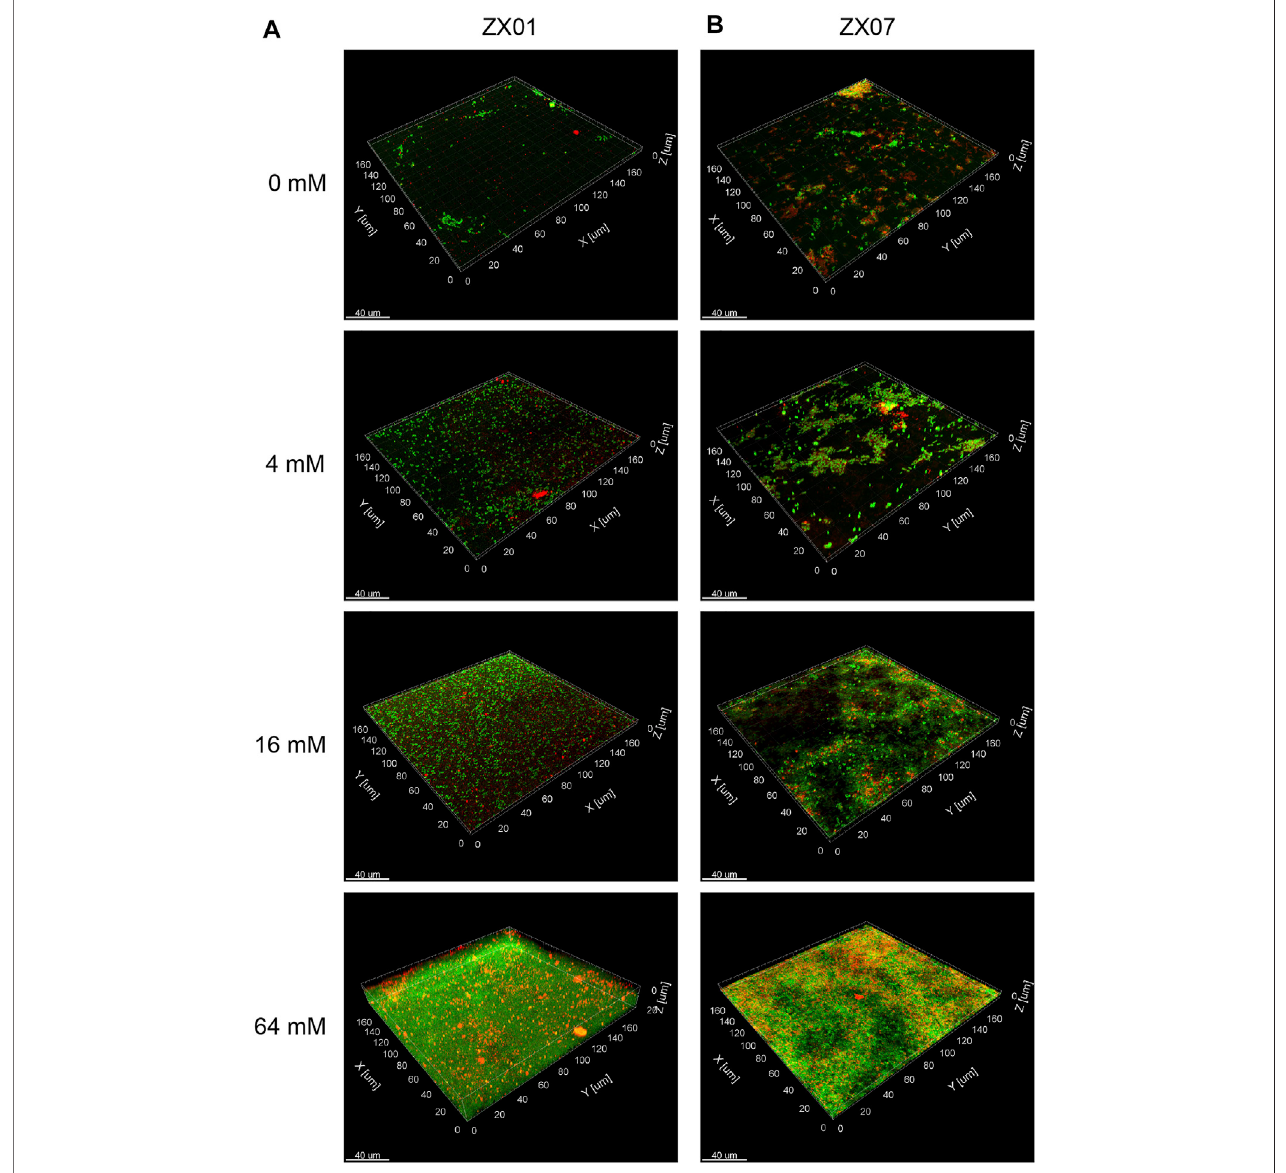
FIGURE 6 | CLSM 3-D images of the bio fi lms formed by Pseudomonas sp. ZX01 (A) and Arthrobacter sp. ZX07 (B) in the presence of 0, 4, 16, and 64 mM of CaCl 2 . The cells were stained green with SYTO9; the polysaccharides were stained red with conA-T; the yellow fl uorescence represented the combination of cells and polysaccharides.